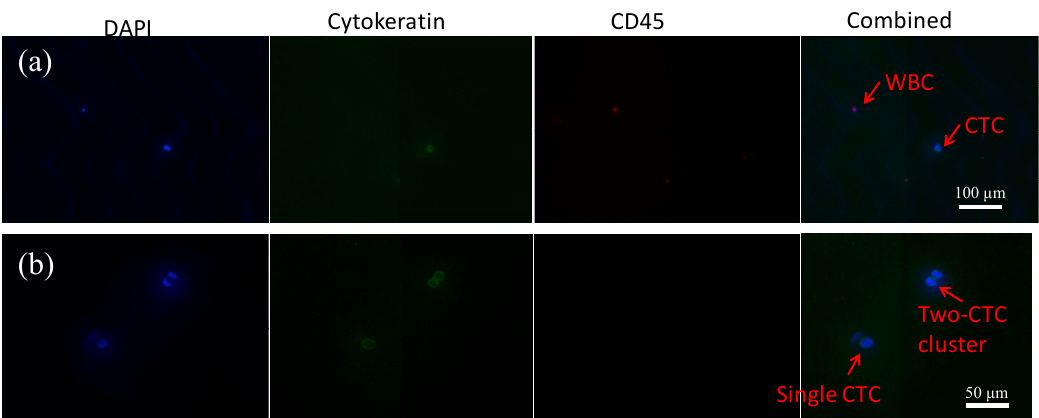
Figure 4. ( a ) Fluorescent images of a single cancer cell and a single WBC captured in the device and stained by DAPI, Cytokeratin-FITC, and CD45-PE. ( b ) Fluorescent images of a single cancer cell and a cancer cell cluster by using the same stain.